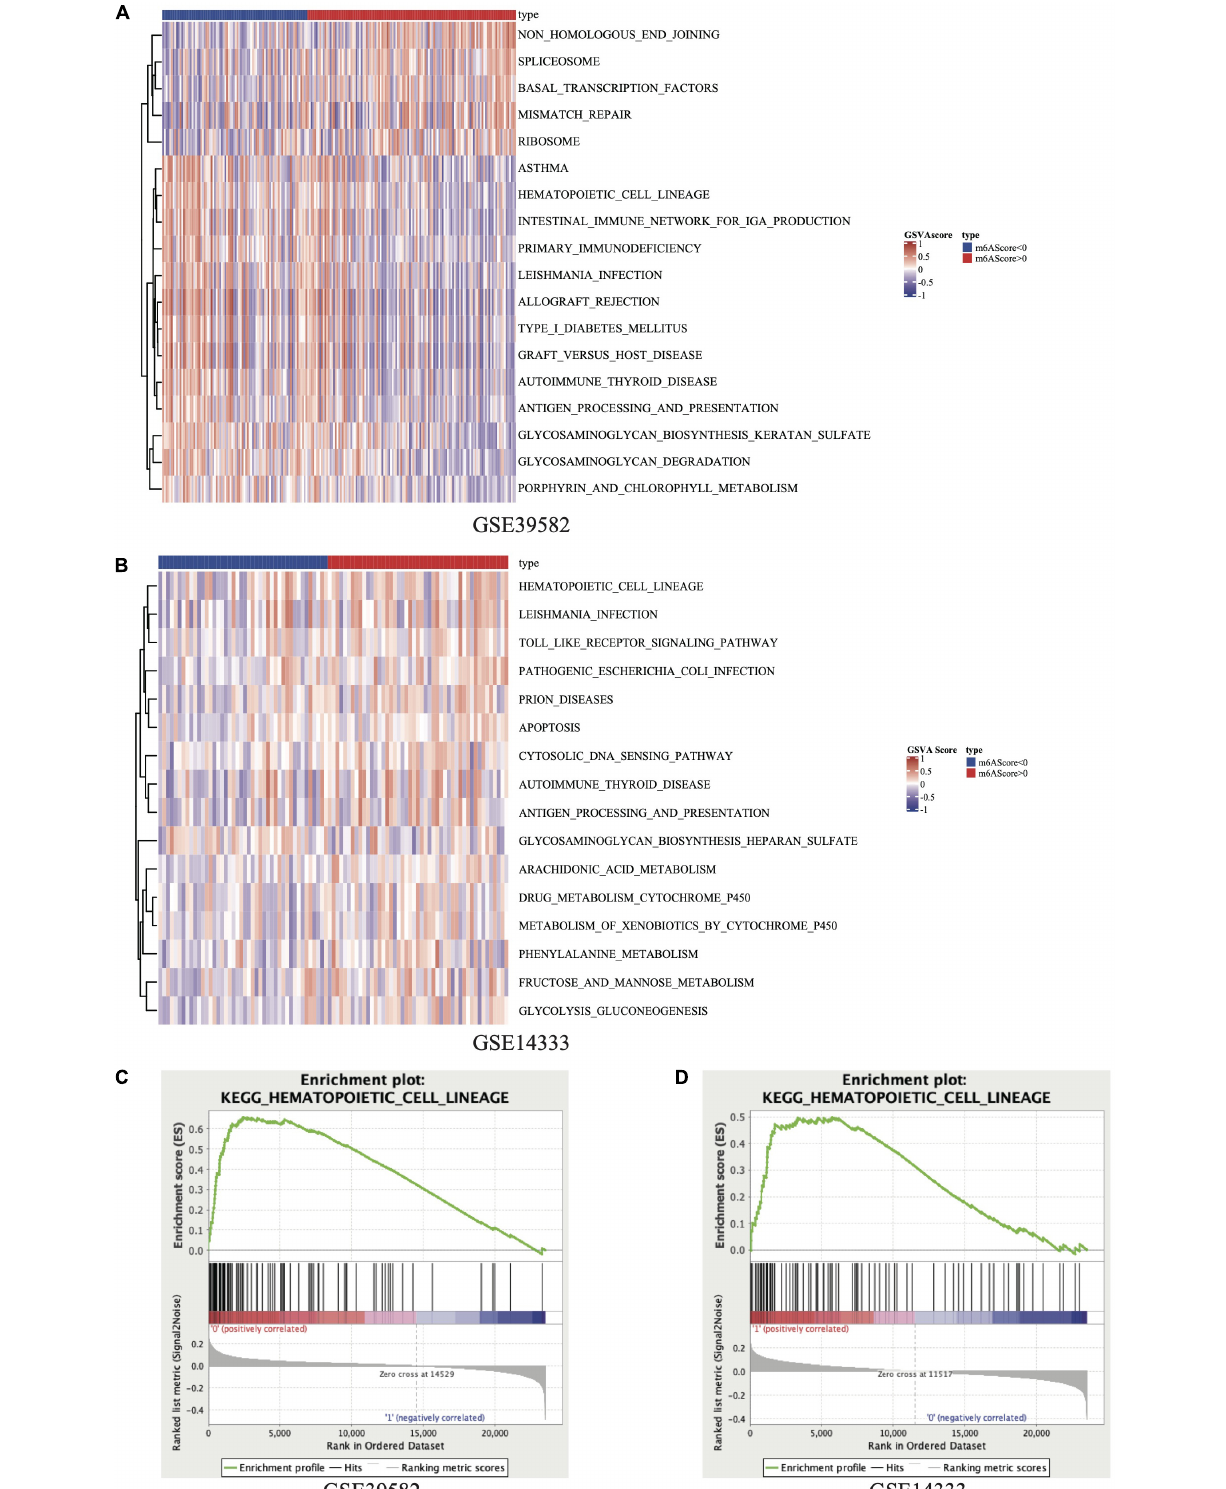
Frontiers in Oncology |